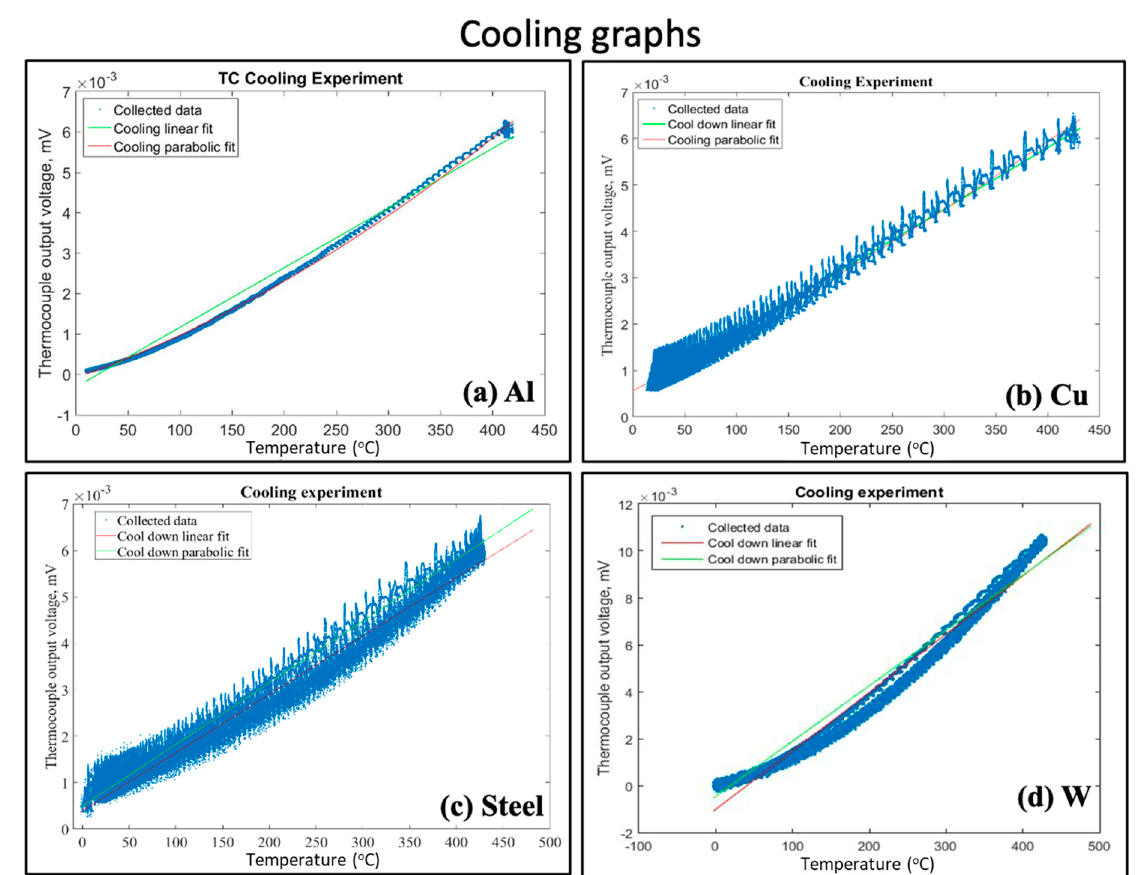
Figure 4. Voltage-temperature plots for ( a ) PG-Al, ( b ) PG-Cu, ( c ) PG-Steel, and ( d ) PG-W TCs obtained from experimental data upon cooling from 500 °C to room temperature.